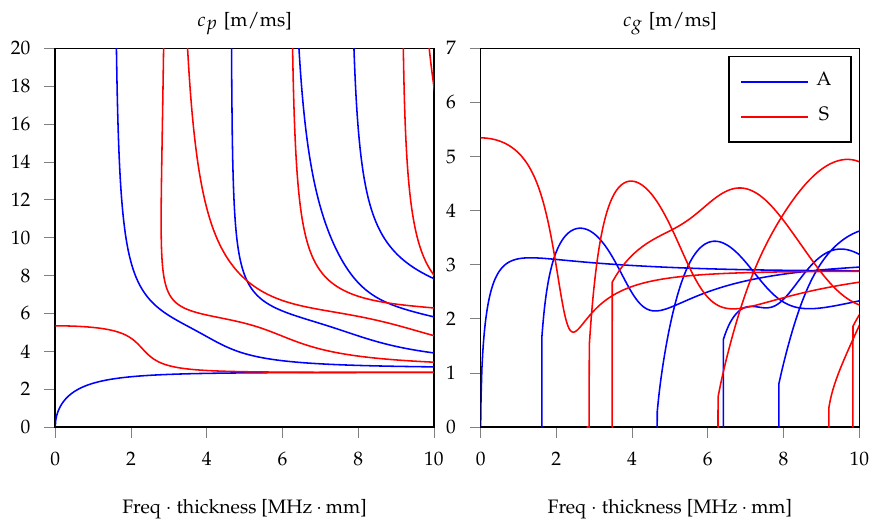
Figure 1. Dispersion curves for an aluminum square plate with 1mm thickness and infinite extension: phase velocity on the left and group velocity on the right